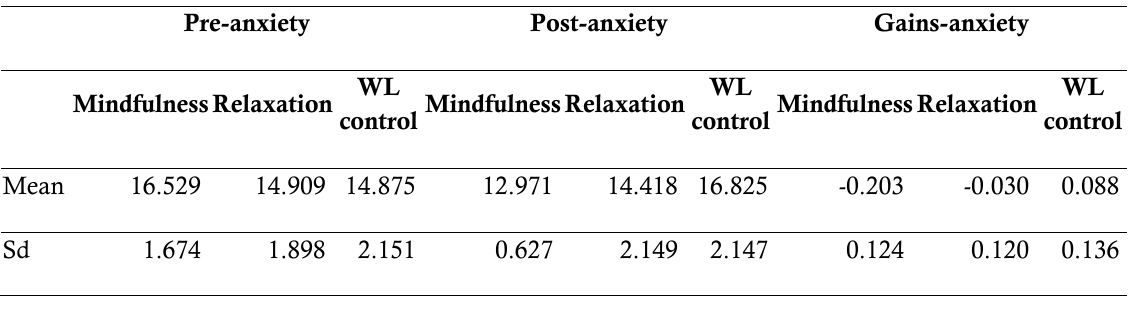
Table 1. Pretest-Posttest Gains Score Anxiety Among Groups